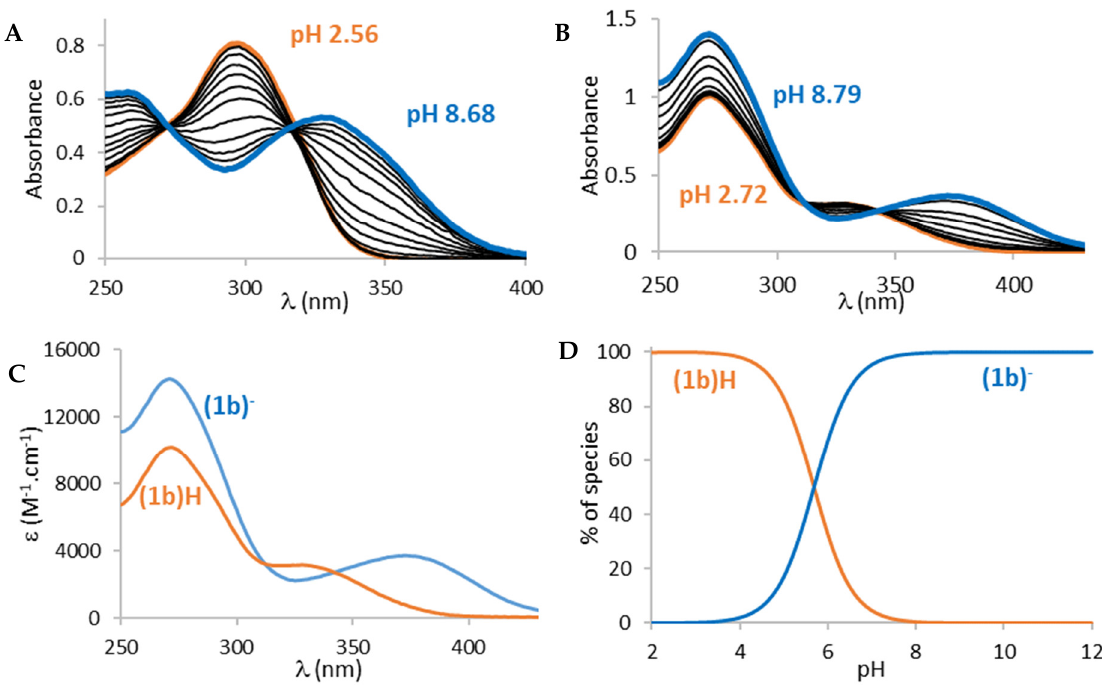
Figure 3. Spectrophotometric titrations vs. pH of ( A ) Ligand 1a between 2.56 < pH < 8.68, [ 1a ] = 5.00 × 10 −5 M and ( B ) ligand 1b between 2.72 < pH < 8.79, [ 1b ] = 1.00 × 10 −4 M. ( C ) Electronic spectra of the protonated species of ligand 1b and ( D ) distribution curves of the protonated species of ligand 1b ([ 1b ] = 1.00 × 10 −4 M). Solvent: MeOH/H 2 O (80/20 w / w ), I = 0.1 M (NaClO 4 ), T = 25.0 °C. N.B.: ( 1b )H represents the protonated ligand, i.e., compound 1b in Scheme 3 and ( 1b ) - the deprotonated ligand.